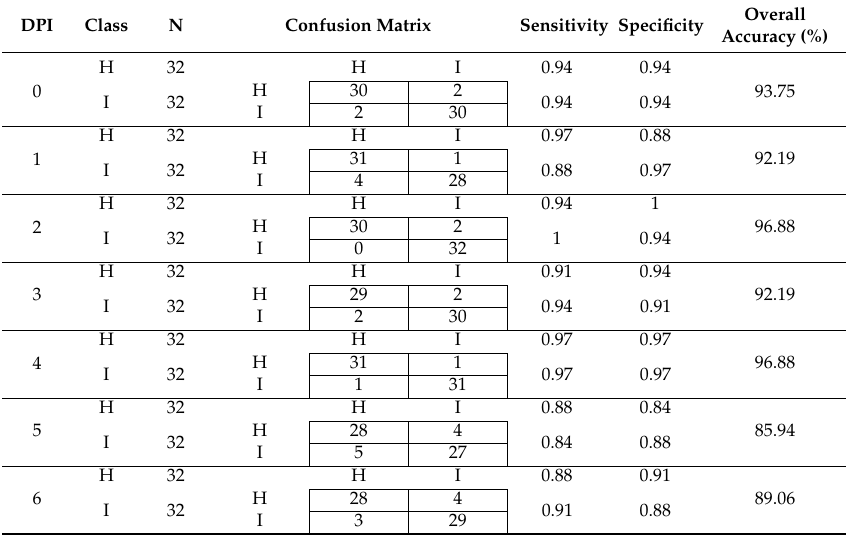
Table 6. Confusion matrix and related statistics when a linear Support Vector Machine (SVM) classifier is applied to the red-edge point (REP) wavelength to classify 32 healthy and 32 infected spectral observations acquired at canopy level as a function of the number of days post-inoculation (DPI). DPI N Confusion